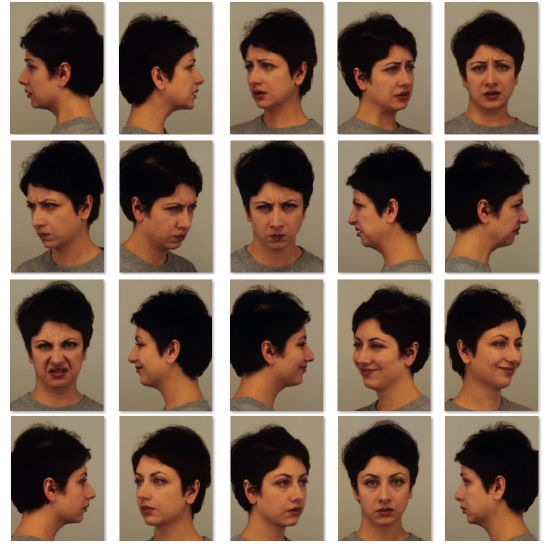
Figure 7. Some image samples from the KDEF